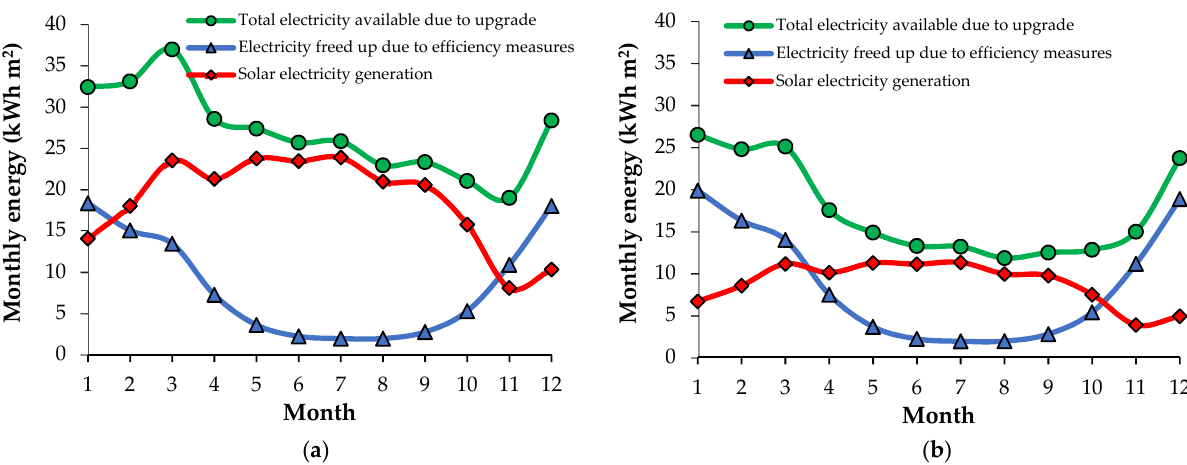
Figure 4. Monthly electricity freed up due to efficiency measures (blue line), solar electricity generation (red line), and total electricity that is made available by (green line): ( a ) a house retrofit; ( b ) rebuilding a house.